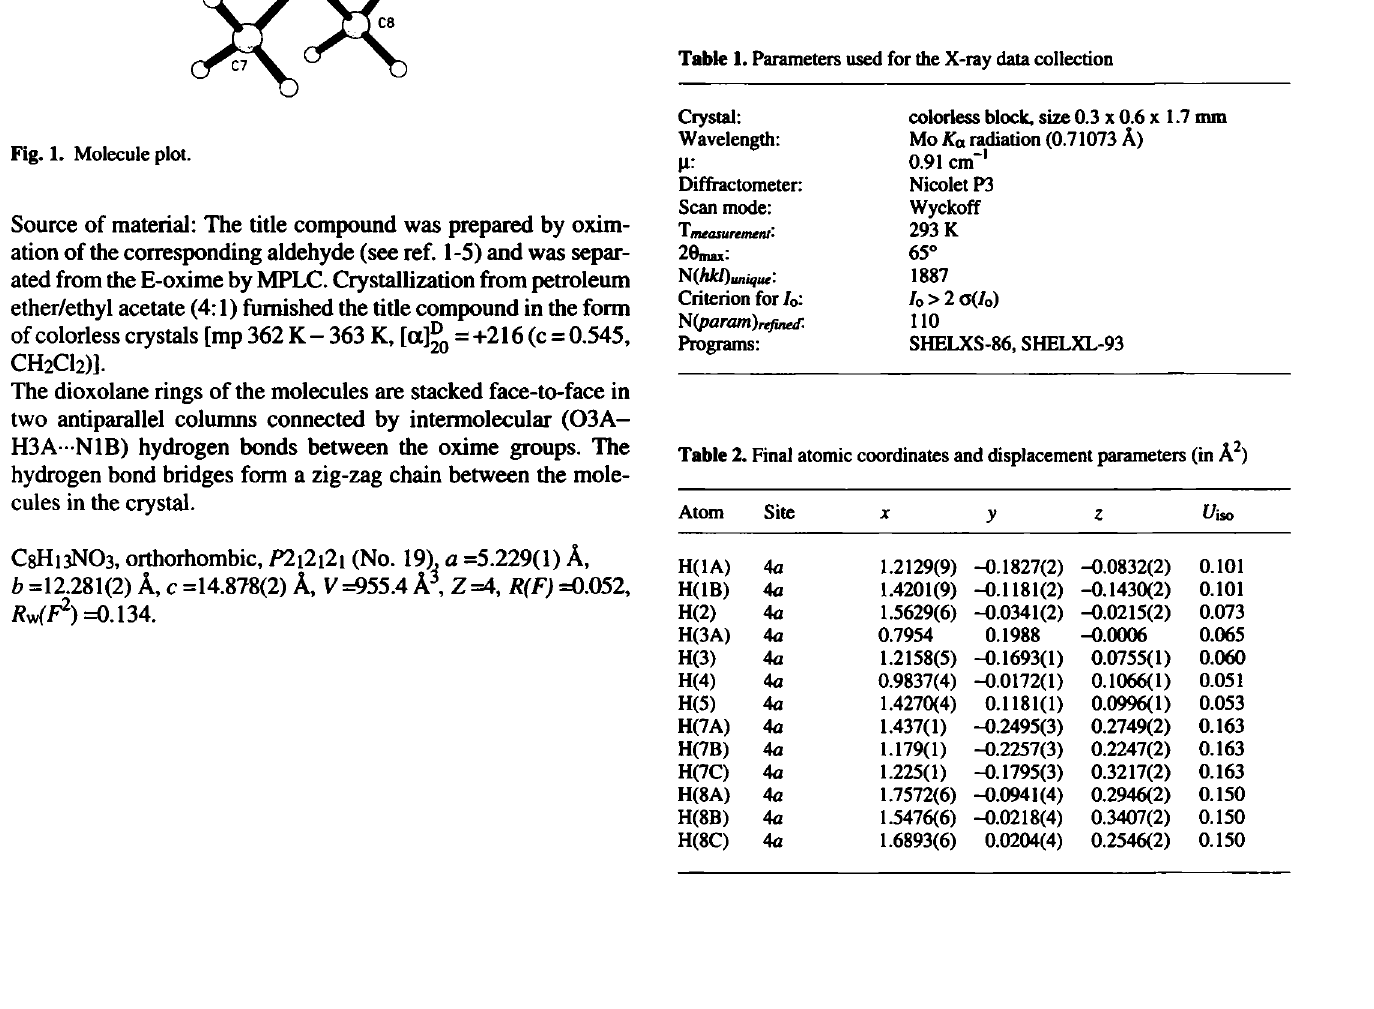
Table 1. Parameters used for the X-ray data collection